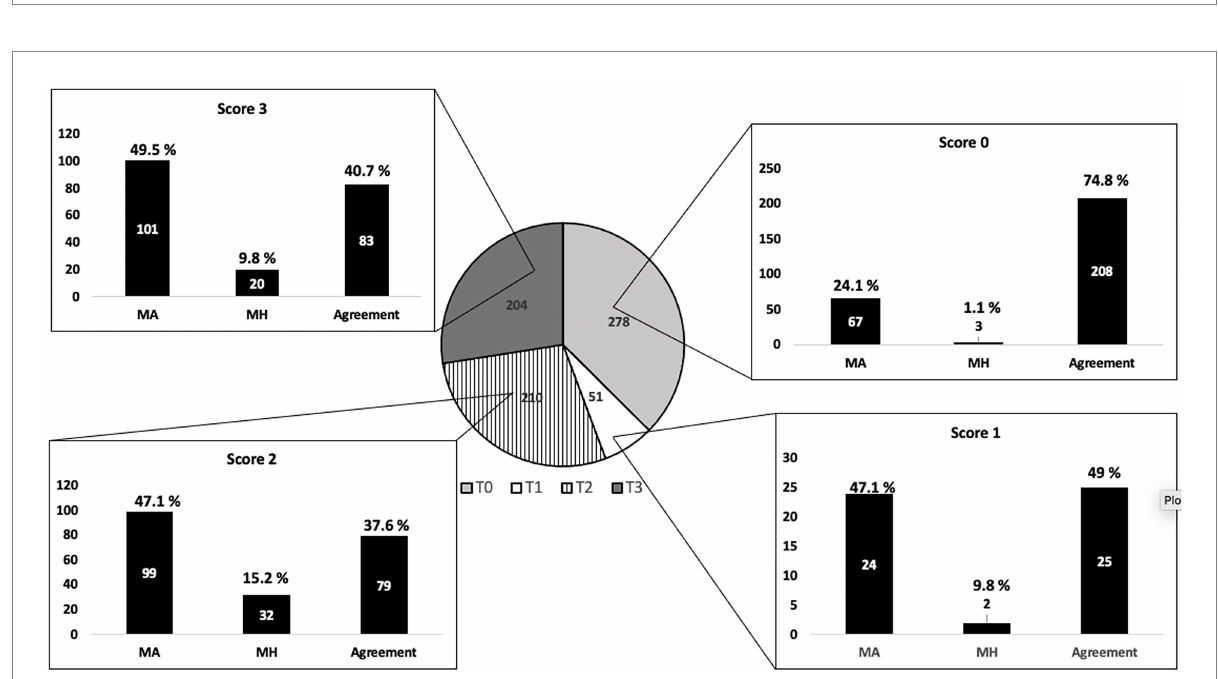
FIGURE 6 Agreement and types of misscores across machine approaches by score category for item